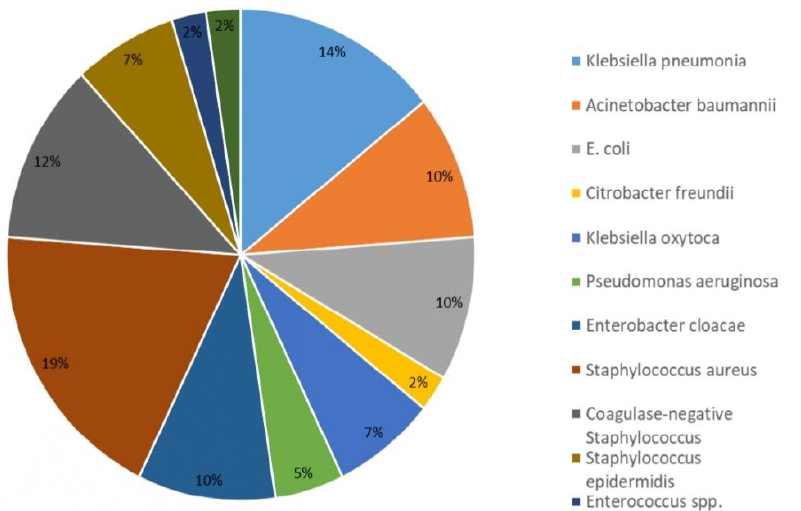
Figure 1. Distribution of the isolated bacterial pathogens in mixed Candida/bacterial bloodstream infections in the Department of Pediatrics, Chang Gung Memorial Hospital, 2005–2020. C. albicans accounted for more than half of all mixed Candida /bacterial BSIs (54.3%, n = 19). The clinical presentations including sources of candidemia, severity of illness, and